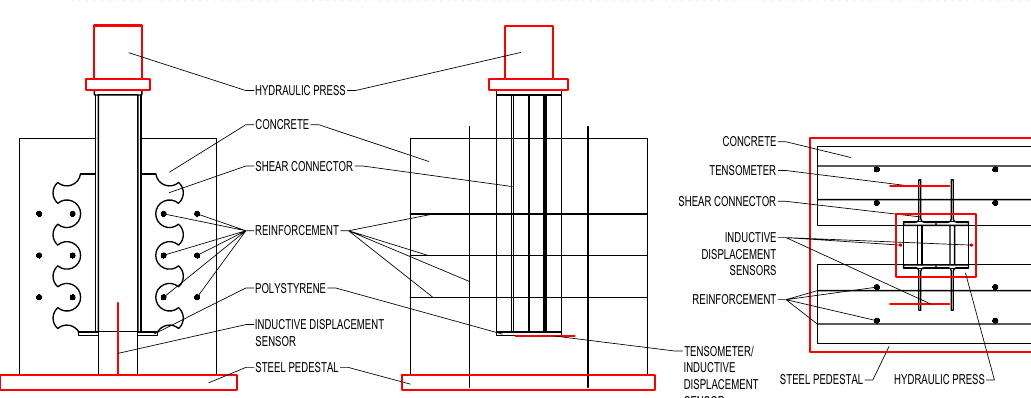
Figure 5. Push-out test setup and instrumentation.